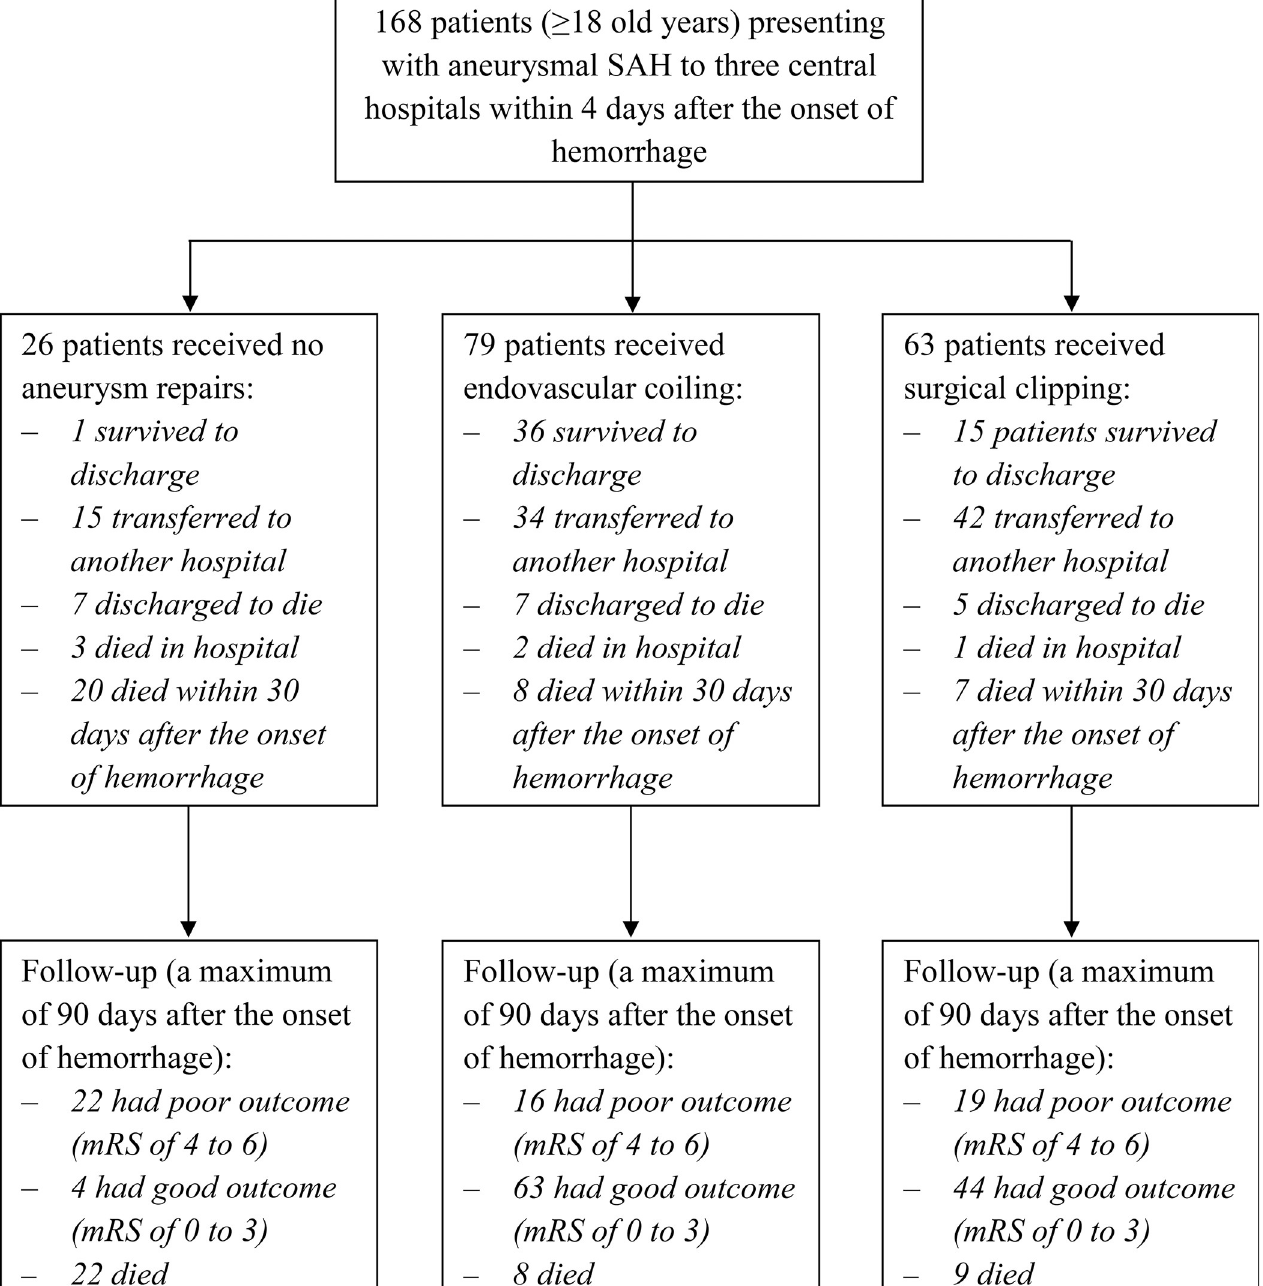
Fig 1. Flowchart of aneurysm treatment and outcome of patients with aneurysmal subarachnoid hemorrhage included in the study (mRS, modified Rankin Scale; SAH, subarachnoid hemorrhage). https://doi.org/10.1371/journal.pone.0256150.g001 a significant difference (p < 0.001) between patients who had a good outcome and patients who had a poor outcome according to the severity of aneurysmal SAH (e.g., WFNS grading scale, Fisher scale, etc.). In addition, ICH (19.8% [22/111] vs. 33.3% [19/57], p = 0.054) and IVH (55.0% [61/111] vs. 80.7% [46/57], p = 0.001) were less commonly detected on the admission